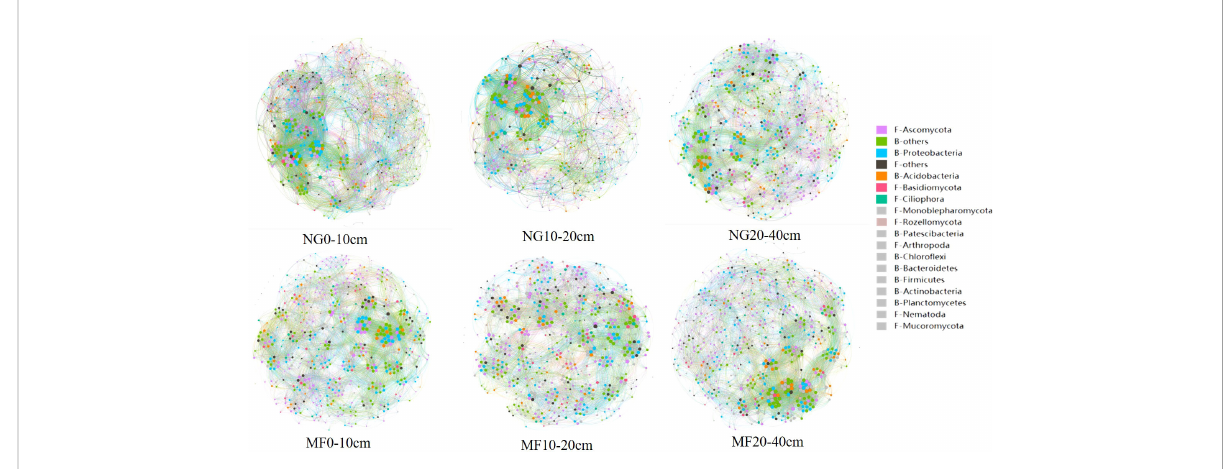
FIGURE 3 Soil bacterial and fungal co-occurrence networks between NG and MF at different depths based on Spearman ’ s correlation coef fi cient (r) at the phylum level (|r| > 0.6, P-value<0.05). Node size is proportional to the connectivity (degree) of each phylum and the different colors indicate different phylum.